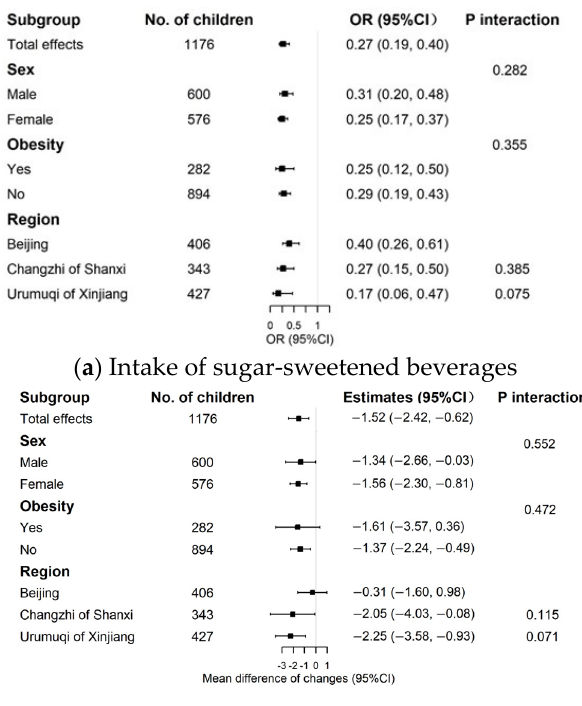
Figure 2. Subgroup analyses of the intervention effects on dietary quality. Figure ( a ) shows the subgroup analyses of the effects on sugar-sweetened beverage intake; figure ( b ) shows the subgroup analyses of the effects on HBS.